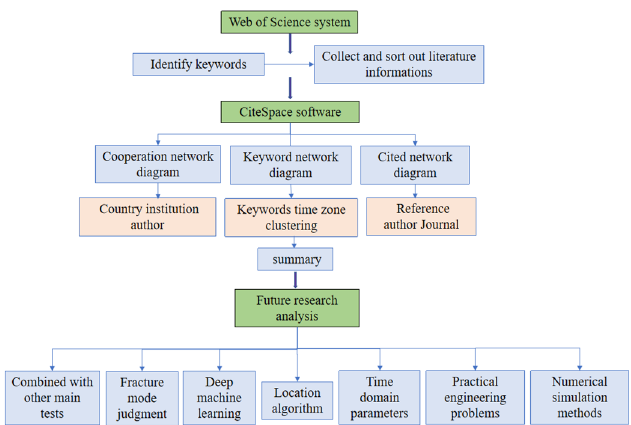
Figure 1. Research flow